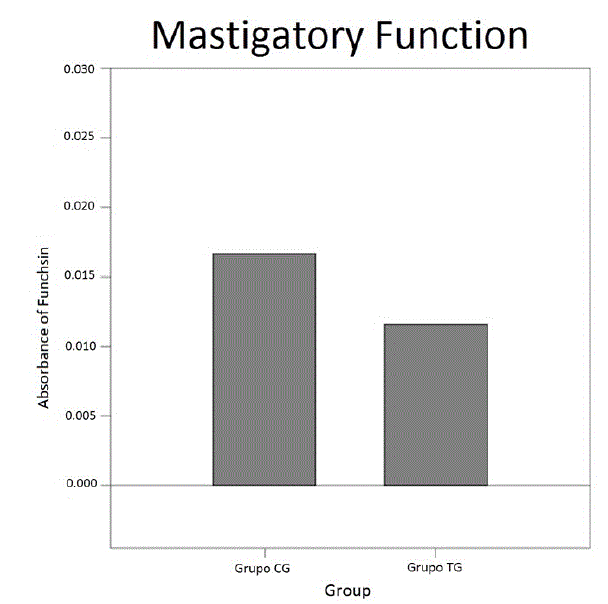
Fig.3. Mean data graphic and standard deviation of the groups and level of absorbance of fuchsin.